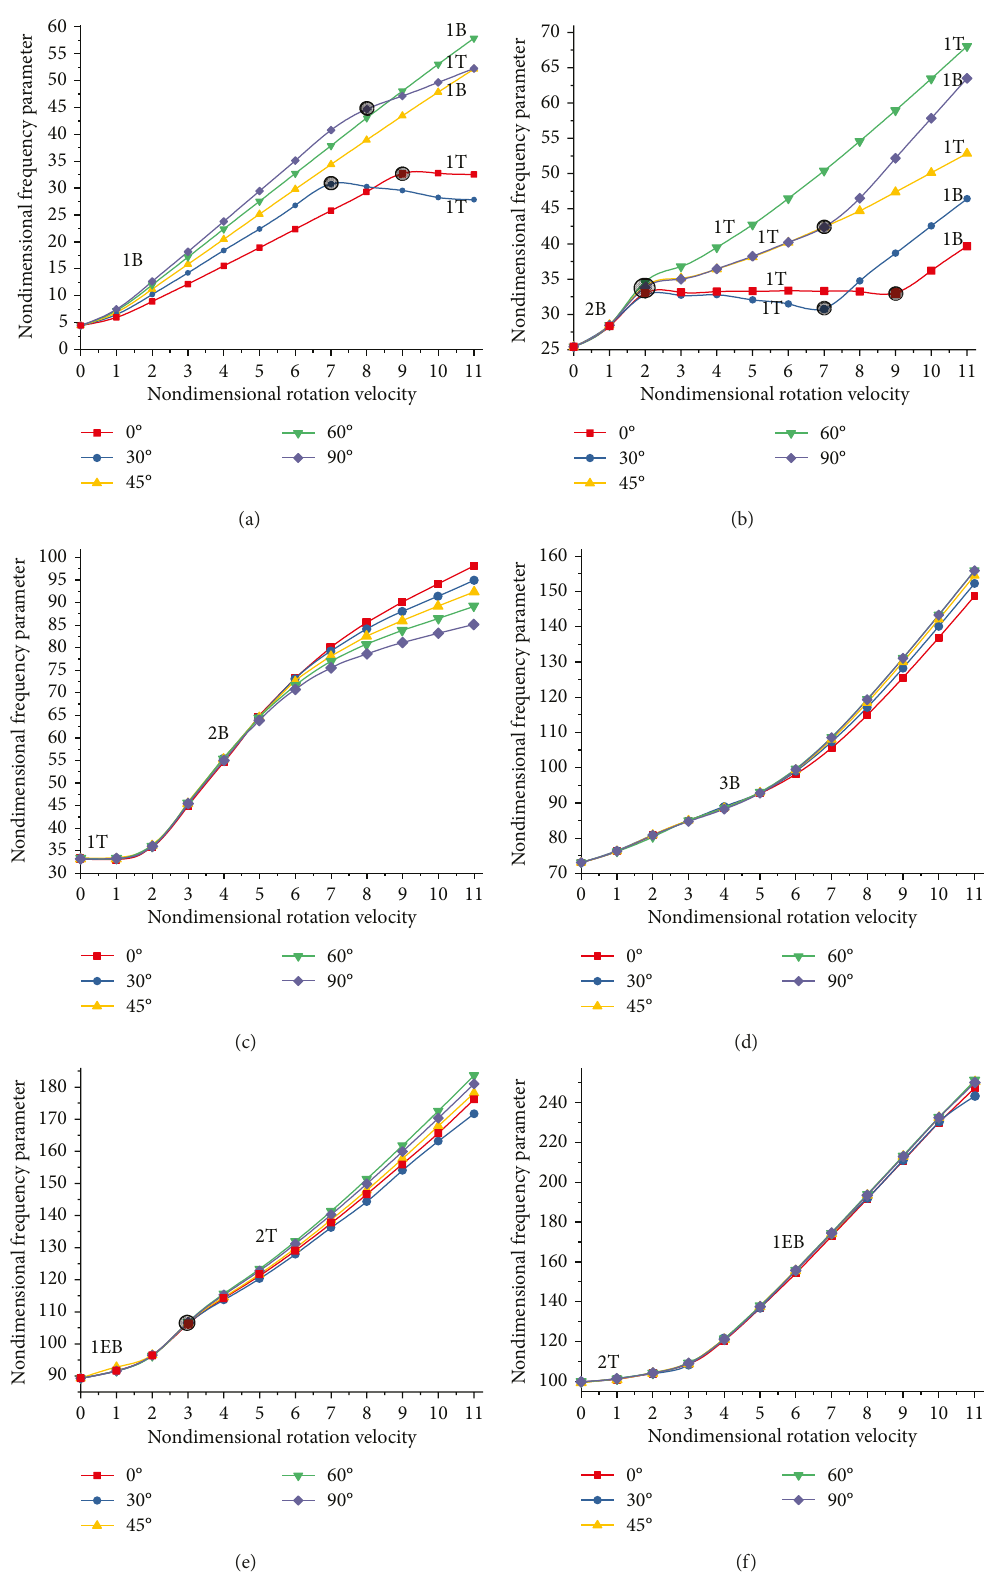
Figure 13: Variations of the fi rst six frequency parameters with the rotation velocity and stagger angles ( l = 3 , h = 20 , n = 2 , h and r = 1 ). (a) 1st mode, (b) 2nd mode, (c) 3rd mode, (d) 4th mode, (e) 5th mode, and (f) 6th